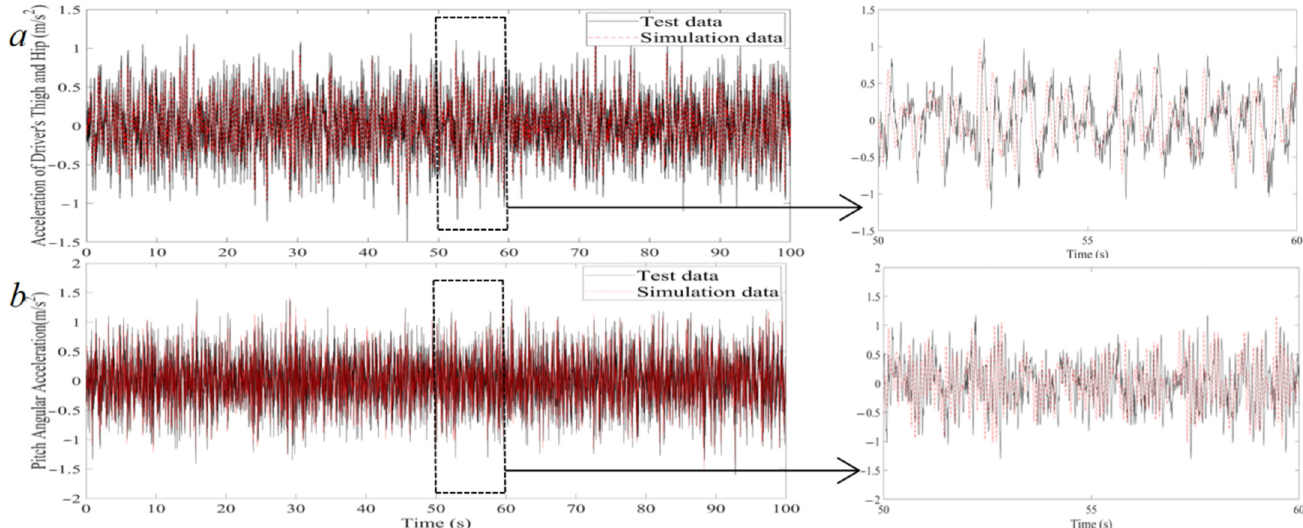
Figure 15. Comparison of performance indicators. ( a ) Acceleration of the driver’s seat support. ( b ) Pitch angular acceleration.